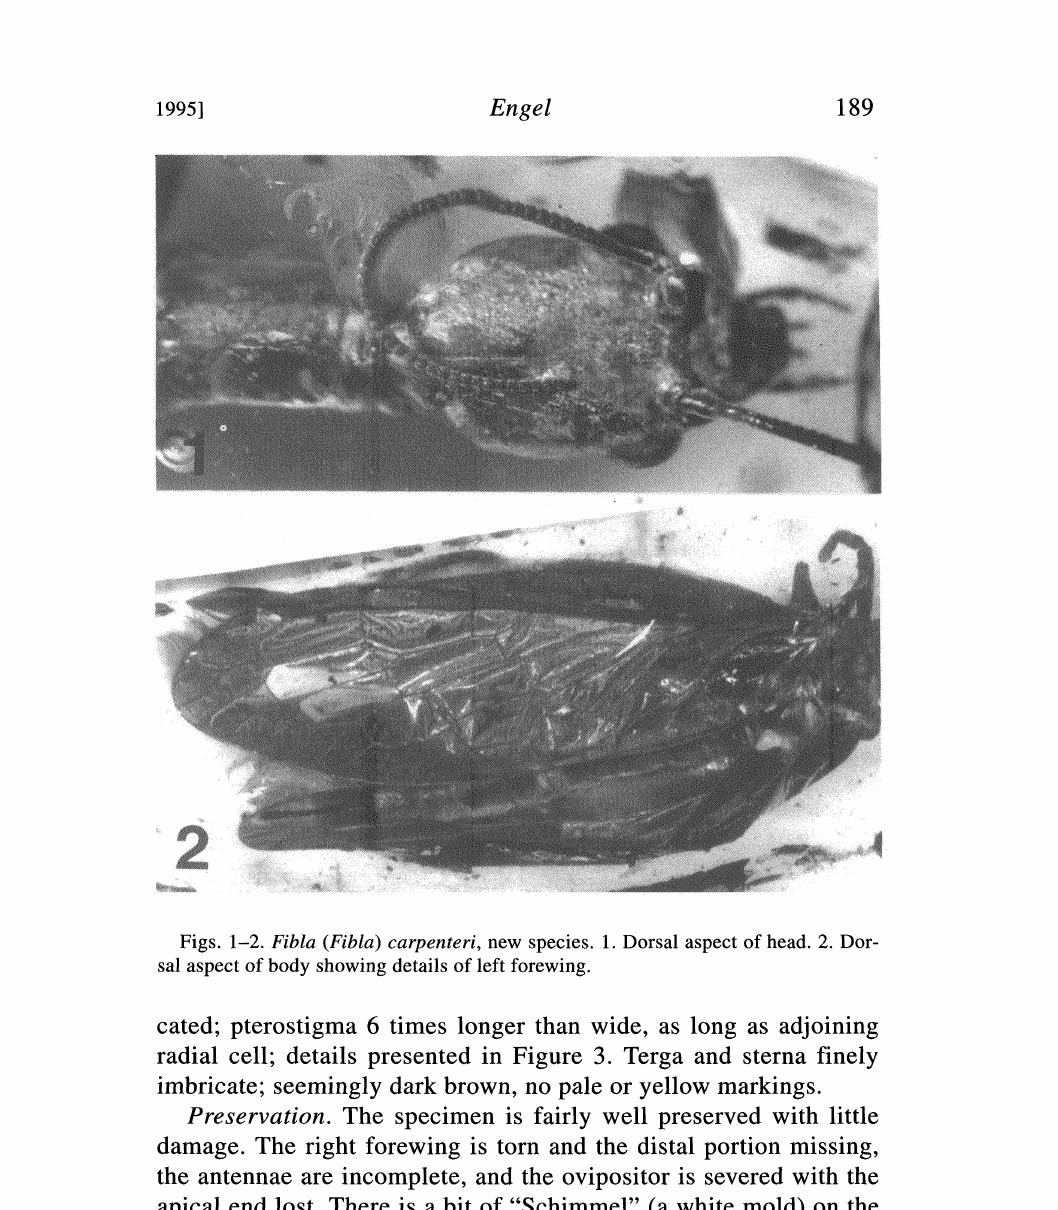
Figs. 1-2. Fibla (Fibla) carpenteri, new species. 1. Dorsal aspect of head. 2. Dor- sal aspect of body showing details of left forewing. cated; pterostigma 6 times longer than wide, as long as adjoining radial cell; details presented in Figure 3. Terga and sterna finely imbricate; seemingly dark brown, no pale or yellow markings. Preservation. The specimen is fairly well preserved with little damage. The right forewing is torn and the distal portion missing, the antennae are incomplete, and the ovipositor is severed with the apical end lost. There is a bit of "Schimmel" (a white mold) on the right anterolateral corner of the mesothorax, base of the right forewing, at the juncture of the meso- and metathorax, under the base of the left forewing, at the base of the right hindwing, and on the right lateral surface of the meso- and